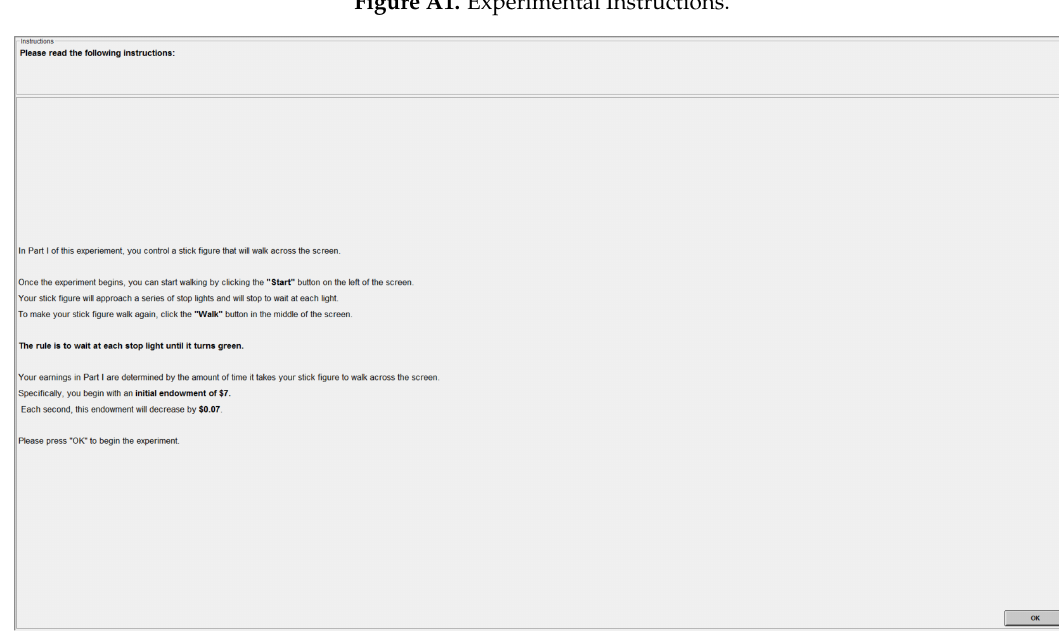
Figure A1. Experimental Instructions.